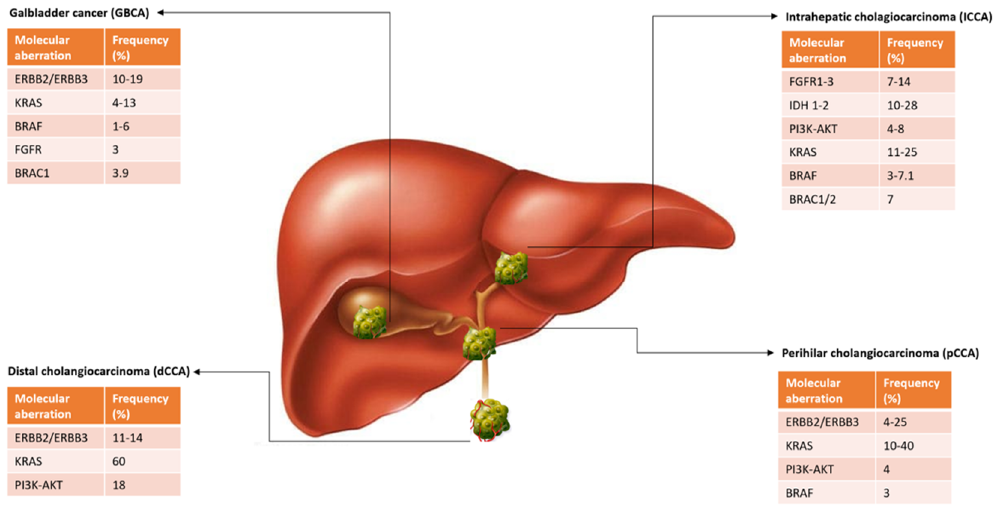
Figure 1. The complex molecular horizon of biological targets in cholangiocarcinoma.